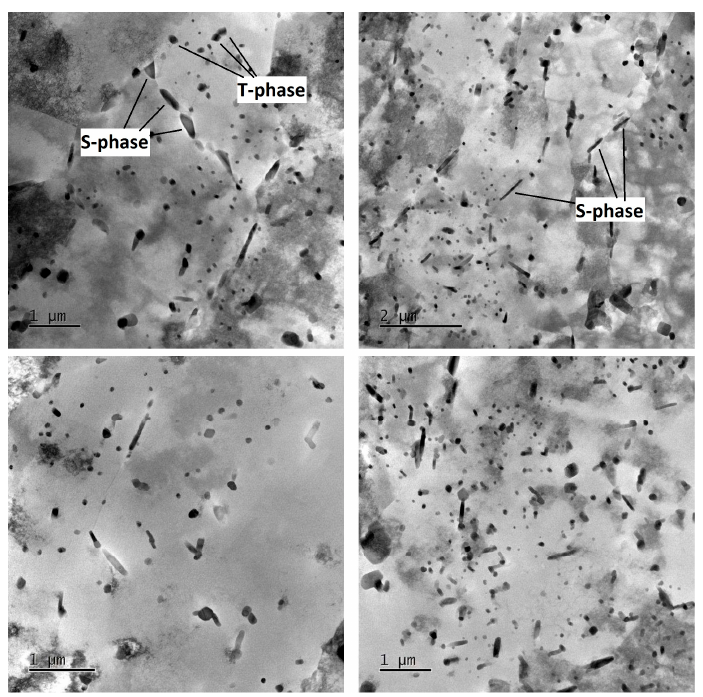
Figure 13. Micrographs of specimen W-1RS-140 at different magnification with marked T-phases and S-phases. Materials 2020 , 13 , x FOR PEER REVIEW 13 of 16